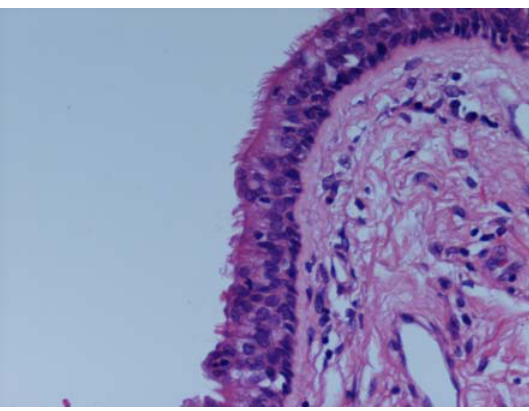
FIGURE 4. Multilayered ciliated columnar epithelial lining of the cyst. Magnification ×